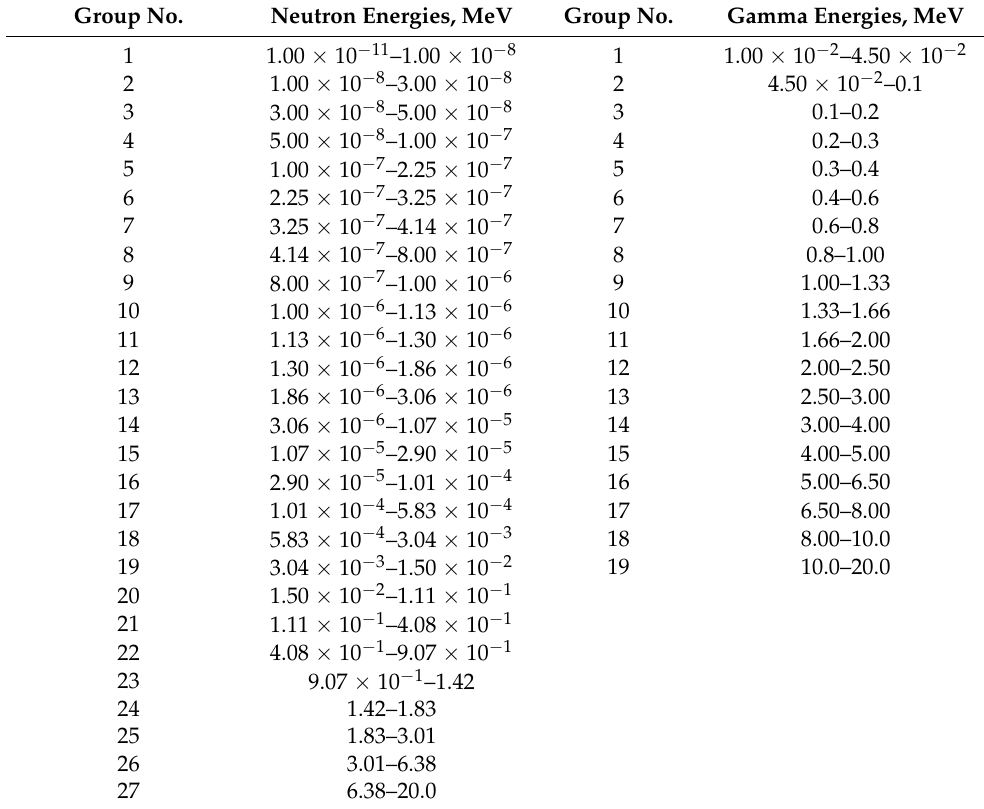
Table 1. Neutron and gamma energy groups and energy